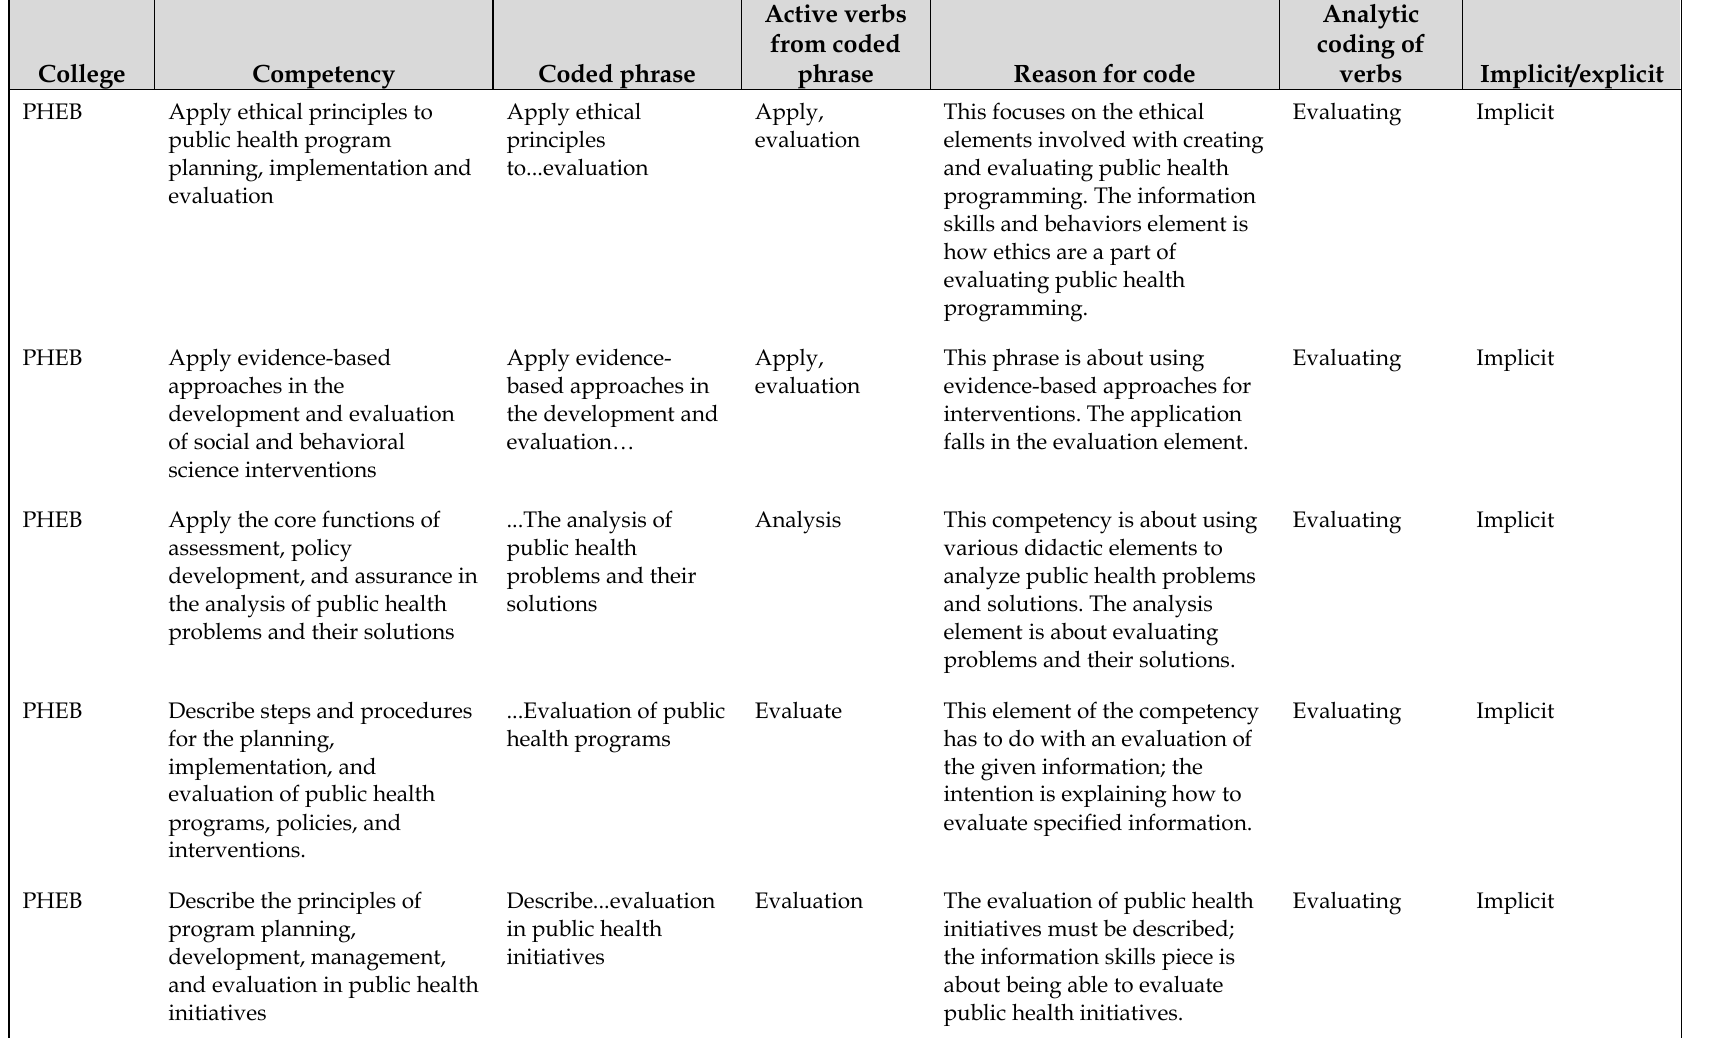
Table 2 Competencies with implicit or explicit information skills and behaviors